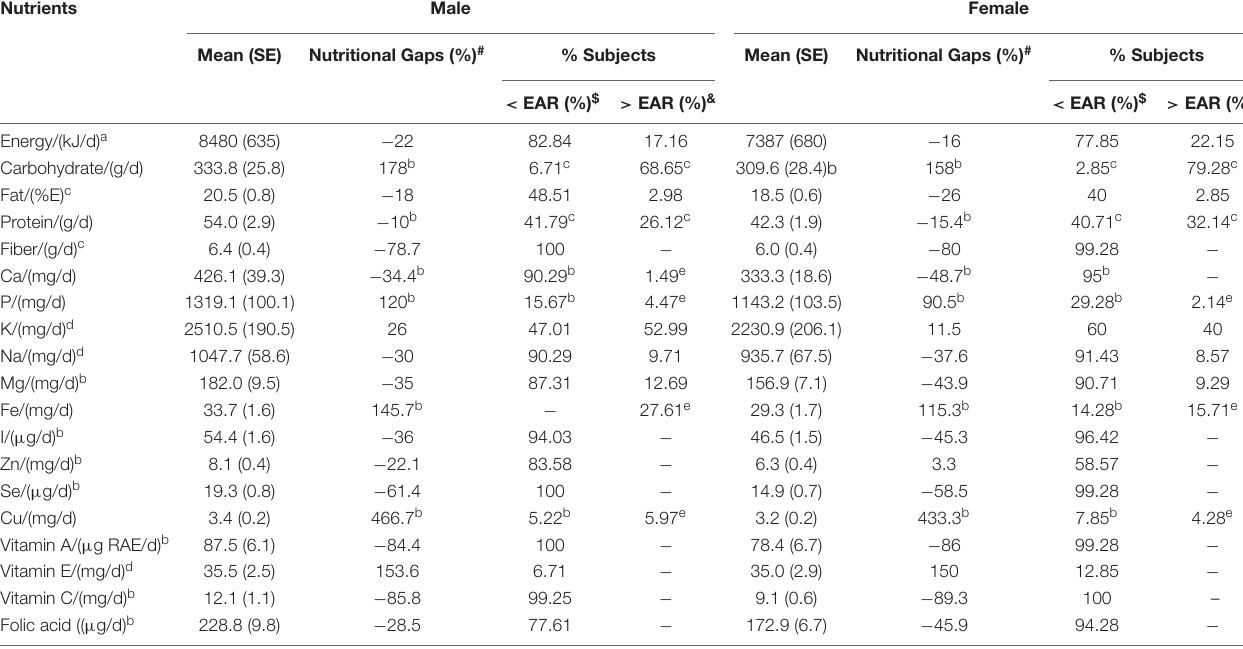
TABLE 3 | Nutrient gaps and prevalence of inadequate and excessive intake of nutrients by gender.